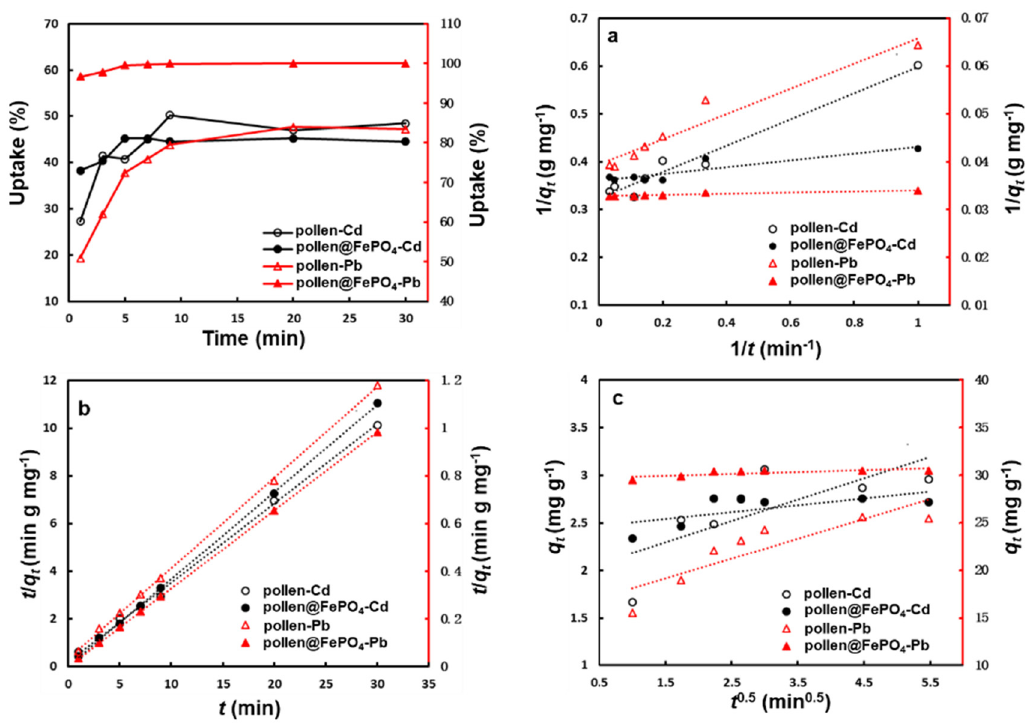
Figure 9: Adsorption kinetics of Cd 2 + /Pb 2 + on pollen@FePO 4 /pollen microspheres: ( a ) pseudo - fi rst order, ( b ) pseudo - second order, and ( c )